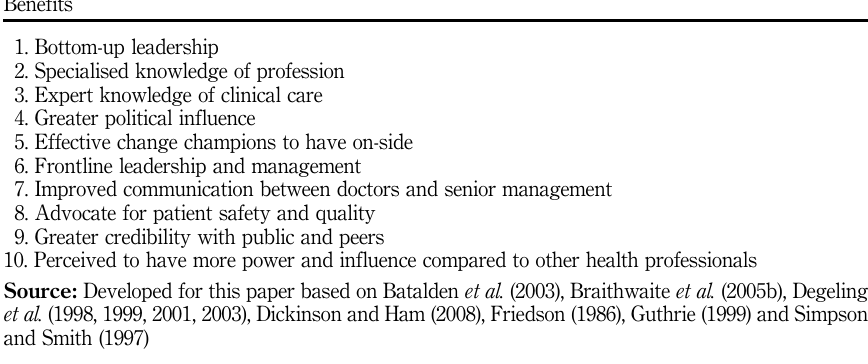
doctors in health management